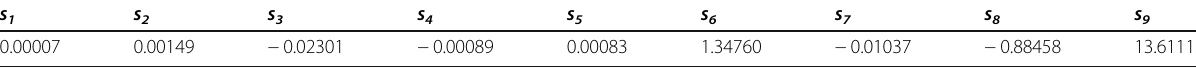
Table 1 Coefficient of the polynomial function representing the regional trend of the Bouguer